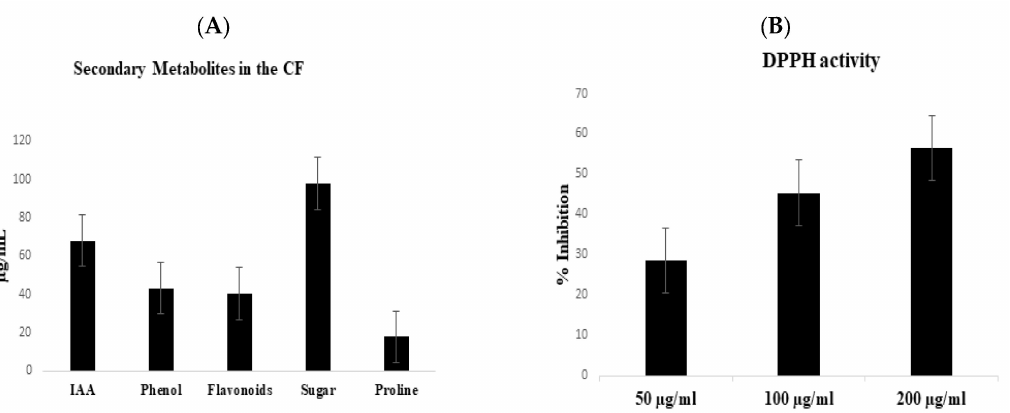
Figure 1. ( A ) Secondary metabolites in the CF of P. lilacinus . IAA = Indole-3-acetic acid, Phe = phenolic and Flav = flavonoids, proline and sugar contents. ( B ) Represents DPPH free radical scavenging activity of the CF of P. lilacinus